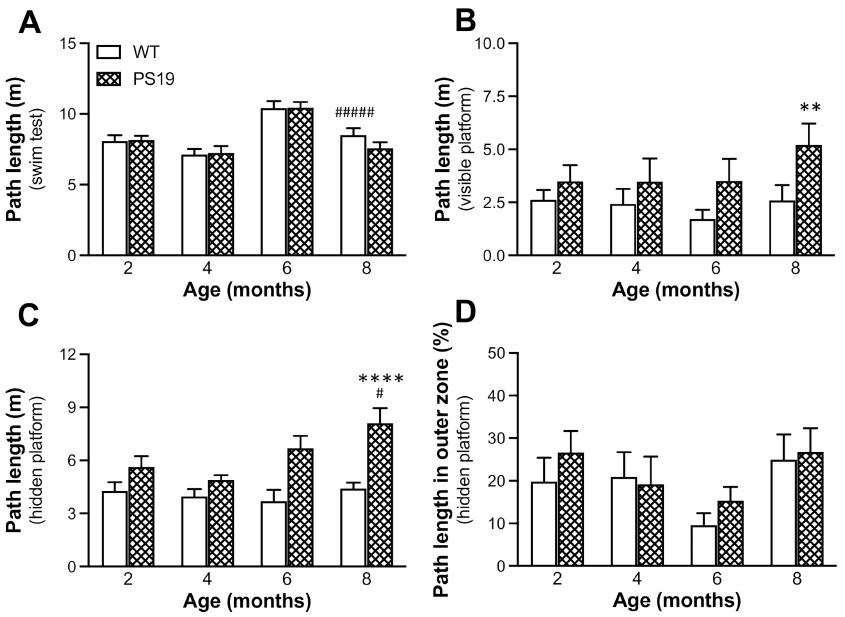
Figure 5. Mean ( ± SEM) path length (m, A – C ) and percentage of path length in the outer zone ( B ) of male wild-type (WT) and PS19 mice at 2, 4, 6, 8 and 12 months of age in the swim test ( A ); cued navigation trial ( B ; visible platform) and place navigation trials ( C , D ; hidden platform) of the water maze test ( n = 11–15/genotype/age). * indicates a significant genotype effect at ** p < 0.01 or **** p < 0.0001. # indicates a significant age effect at # p < 0.05 or ##### p <